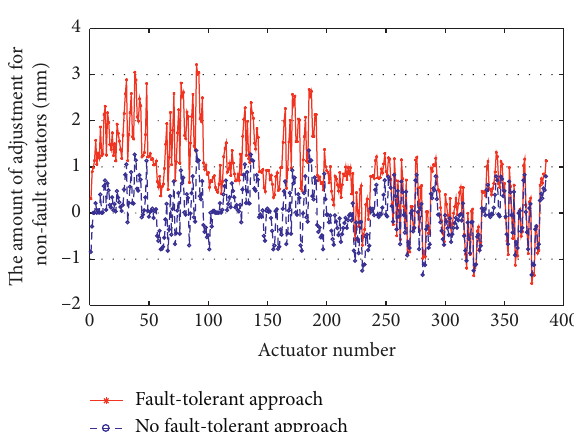
Figure 5: Nonfault actuators’ stroke at 0deg